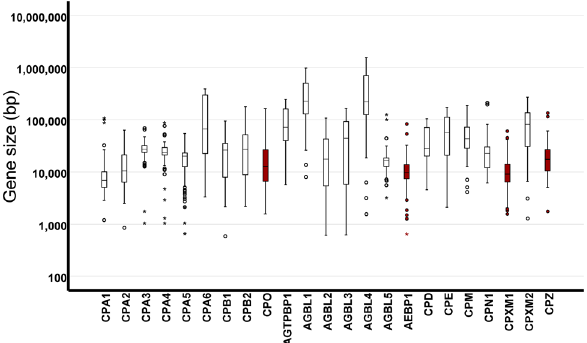
Figure 4. Gene size may contribute to rate of gene duplication or duplicate maintenance. The sizes of the indicated genes from 188 species were obtained from Ensembl (Release 98). An independent sample t test was performed comparing all frequently duplicated genes (red) to all others (white; p =